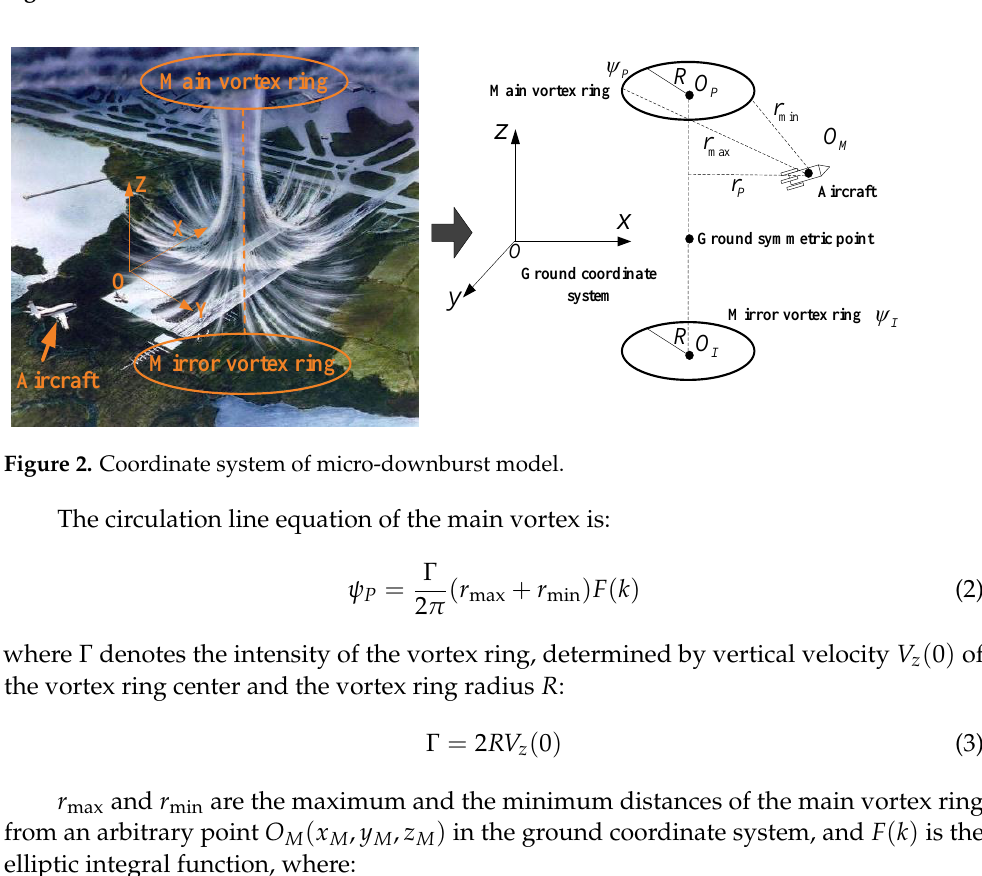
Figure 1. Airflow distribution of micro-downburst.